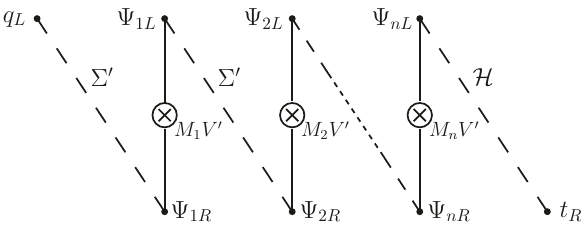
Figure 1 . Yukawa couplings between the fermion multiplets that collectively break the pNGB shift symmetry in a special \chain form". There is a similar construction for the twin